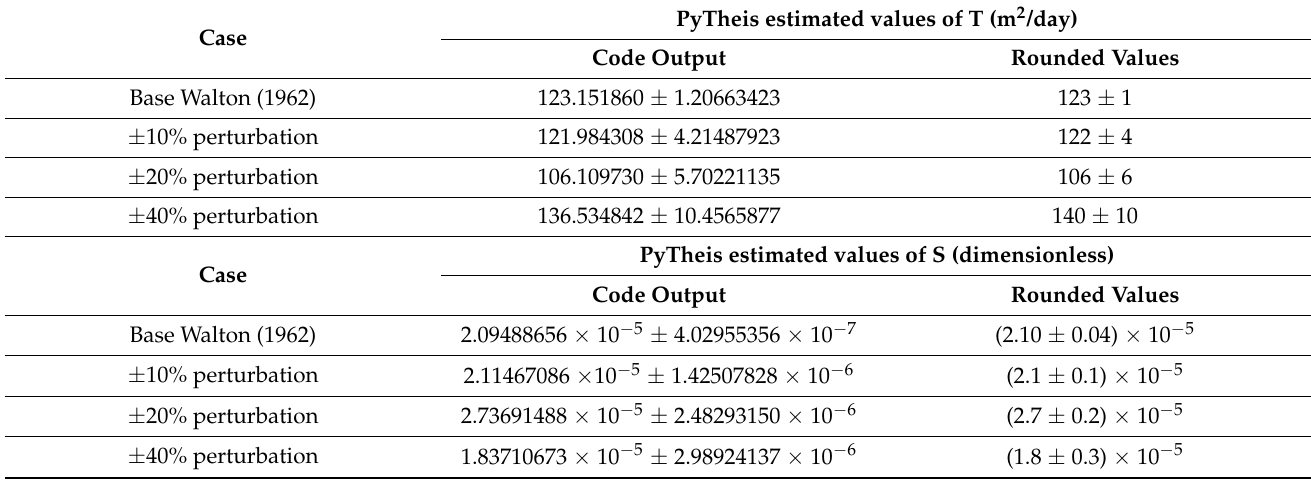
Table 3. PyTheis estimated T and S values for the perturbed Walton (1962)